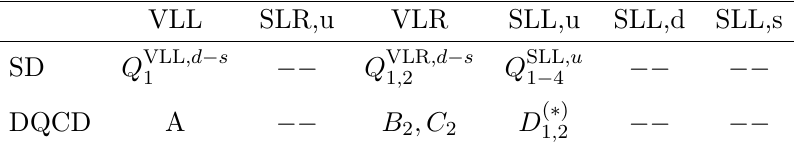
Table 1 . SD and DQCD BSM operators generated in